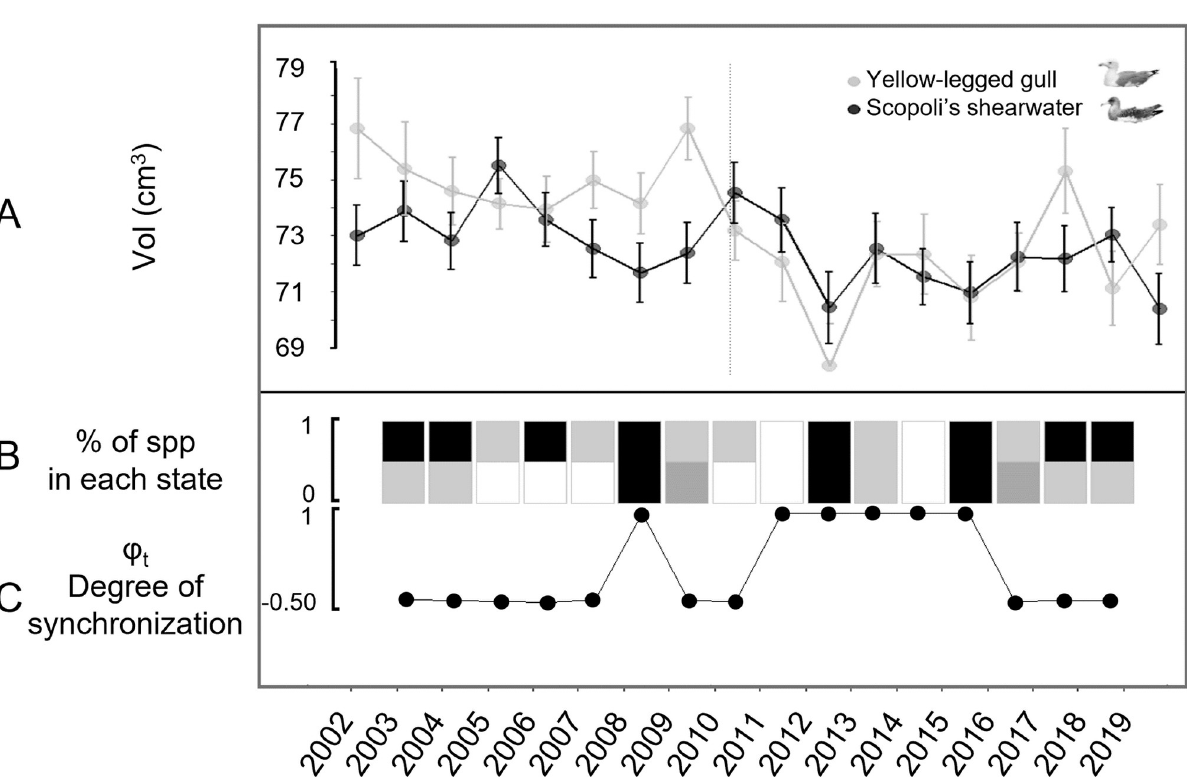
Fig 1. Scopoli’s shearwater and the Yellow-legged mean egg volume synchrony results. a) Mean egg volume 95% confidence intervals (grey) of the Scopoli’s shearwater and the Yellow-legged gull (black) breeding at Dragonera Natural Park (2002–2019, Spain). Vertical dashed line indicates landfill closure. b) Proportion of species in: state1 (trough, black); 2 (increase, grey stripped); 3 (peak, white); and 4 (decrease, grey). c) Synchrony score values ( F t ), 1 = synchrony dynamics.